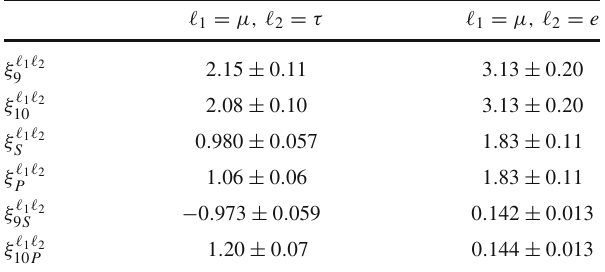
Table 1 Numerical values for the parameters of Eq. (15). The coeffi- cients do not depend on the charges of the final state leptons, except for ξ (cid:3) 1 (cid:3) 2 which changes sign when switching the charges of the leptons, i.e. 9 S ξ τμ from the form factor which are the dominant